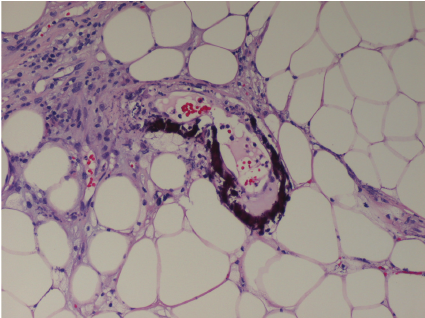
Figure 2: Skin biopsy with demonstration of vascular